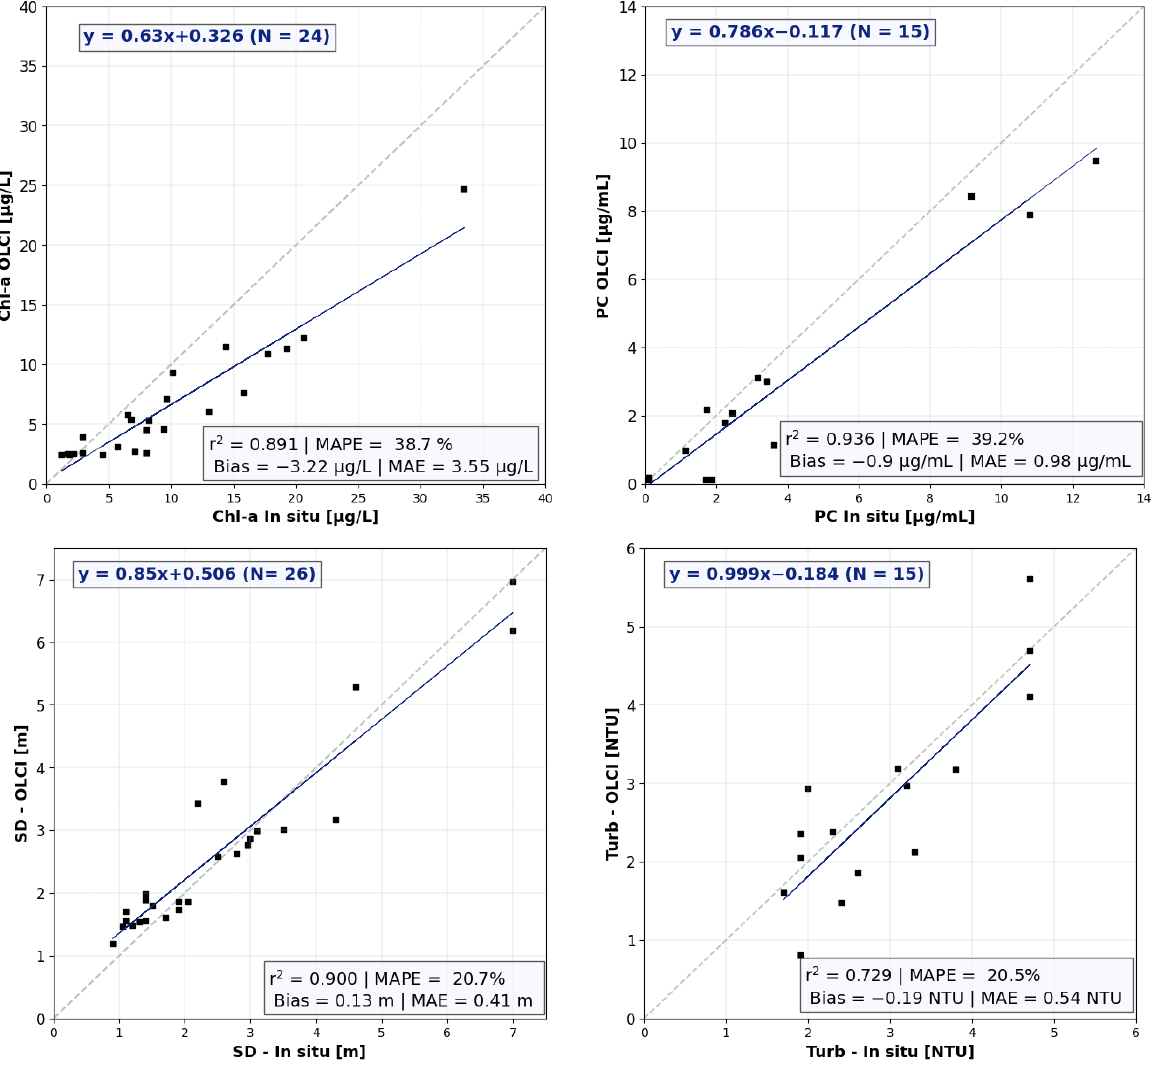
Figure 6. Scatter plot of predicted versus measurements/laboratory data (Chl-a and PC on the top panel; SD and Turb on the bottom panel).